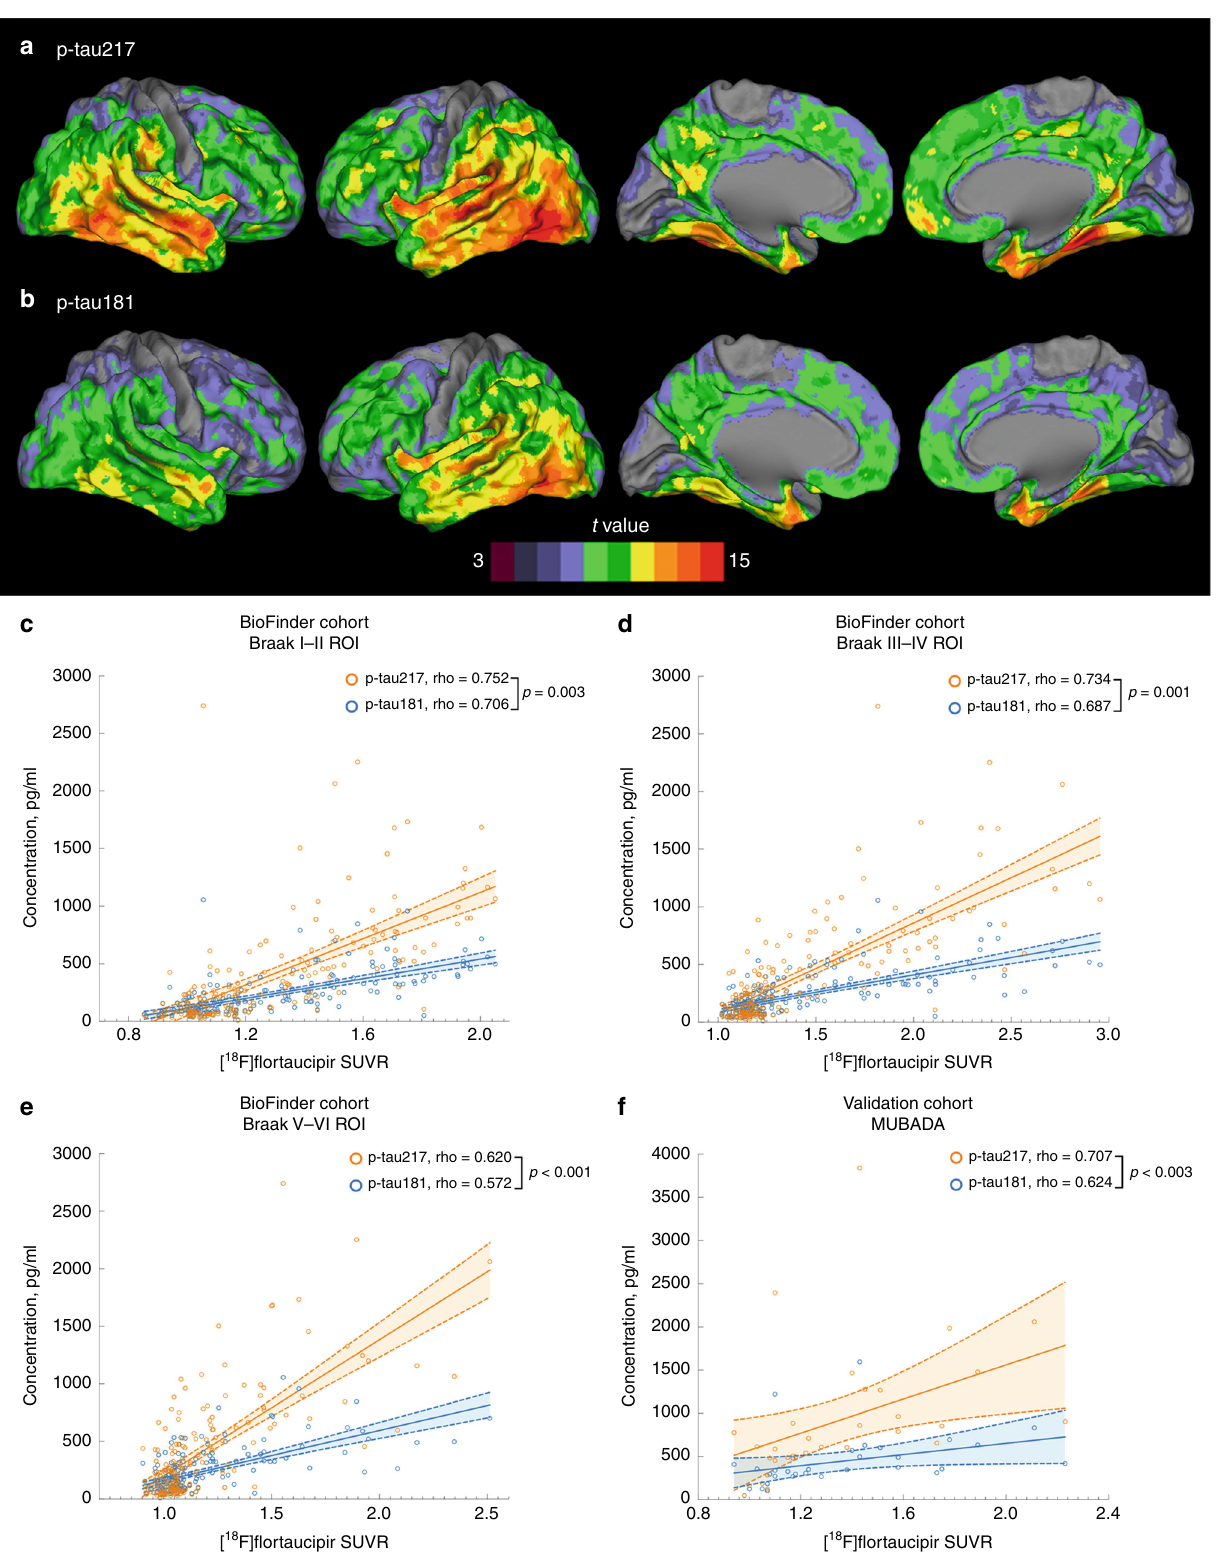
Fig. 2 Associations between[ 18 F] fl ortaucipir and p-tau. a , b BioFINDER cohort, voxel-wise regression analysis of p-tau217 ( a ) and p-tau181 ( b ) vs [ 18 F] fl ortaucipir corrected for age. c – e BioFINDER cohort, associations between [ 18 F] fl ortaucipir retention in a priori de fi ned brain regions linked to tau pathology in AD and CSF p-tau217 and p-tau181. f Validation cohort, associations between [ 18 F] fl ortaucipir MUBADA SUVR and CSF p-tau217 and p-tau181. In c – f , data are shown as Spearman correlation coef fi cients (rho), lines are linear regression lines with 95% CI (shaded area). Differences between the correlation coef fi cients were tested using estimated Spearman coef fi cients and method described in Rosner et al. 63 . Abbreviations: ROI region of interest, SUVR standardized uptake value